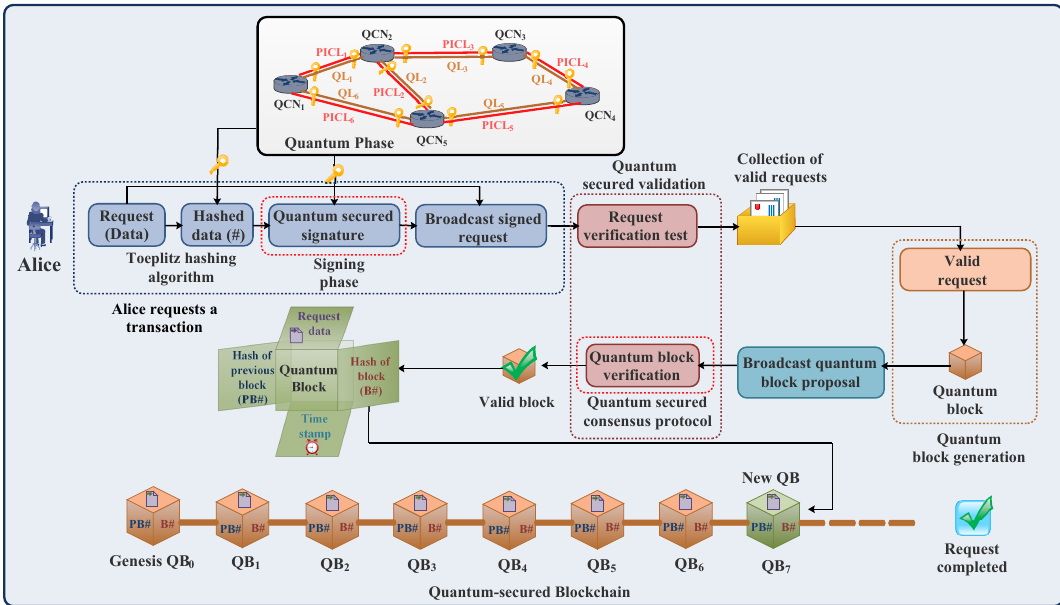
Figure 9. Process of quantum-secured blockchain